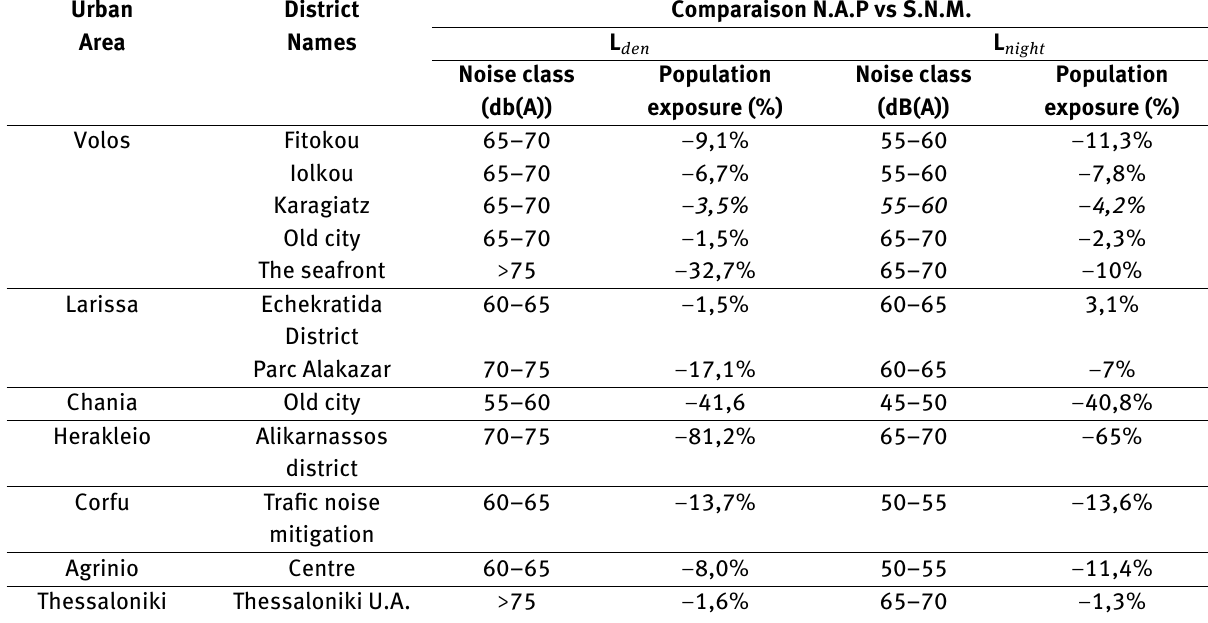
Table 5: Best results expected form the Noise Action Plan in the 7 urban areas and studied districts.